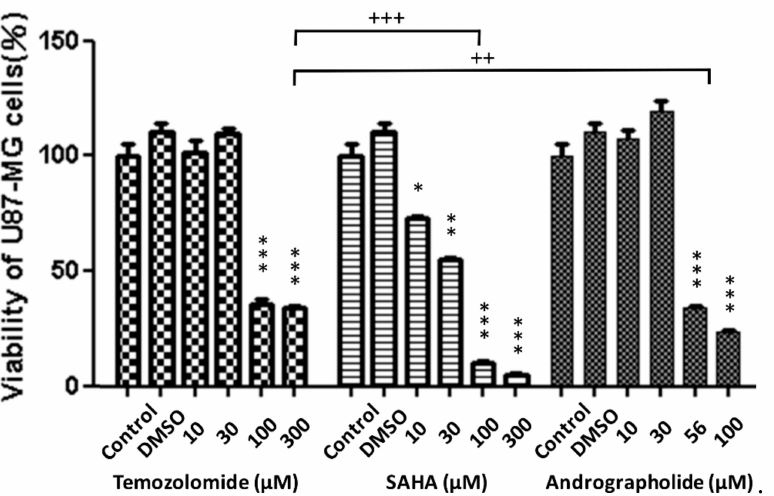
Figure 2. E ff ects of TMZ, SAHA, and andrographolide on cell viability. Cell viability of U-87 MG cells cultured in 96-well plates under the e ff ect of 10–300 µ M TMZ, SAHA, and andrographolide for 24 h compared with cells without drugs and with DMSO. Cells were analyzed using the Alamar blue cell viability assay. Results are expressed as mean ± standard error. *versus control. * p < 0.05, ** p < 0.01, *** p < 0.001, ++ p < 0.01, +++ p <